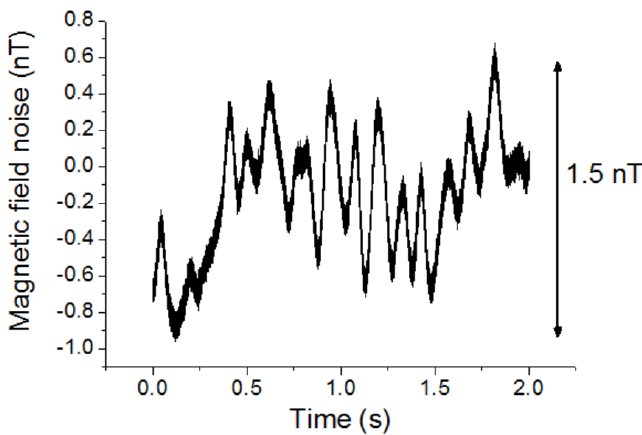
Figure 14. DC magnetic field noise of the magnetic sensor with a 10 Hz low-pass filter.